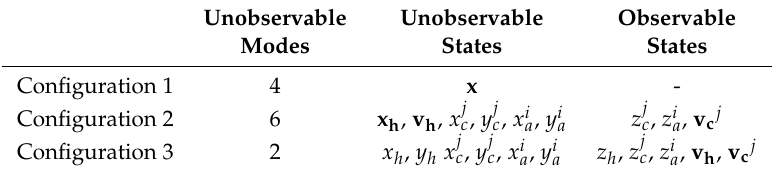
Table 2. Results of observability in the absence of